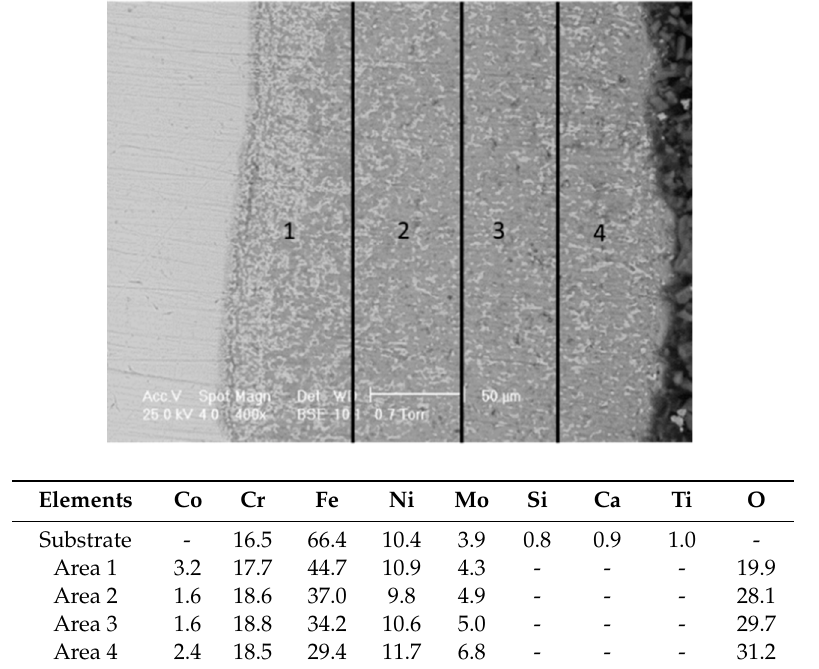
Figure 8. Back scattered electron (BSE) image of the cross-section of the CoCrFeNiMo coating and results from EDS analysis of the areas labelled in the BSE image.